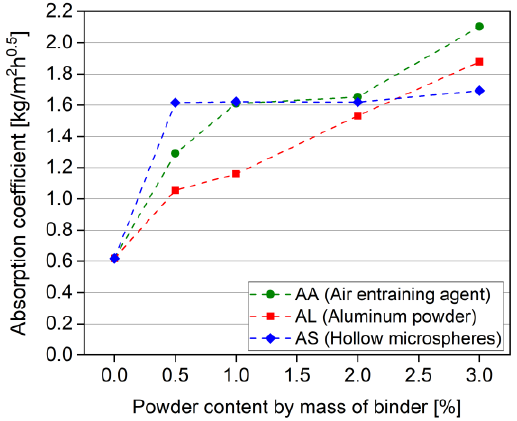
Figure 5. Water absorption of the specimens with different additives.